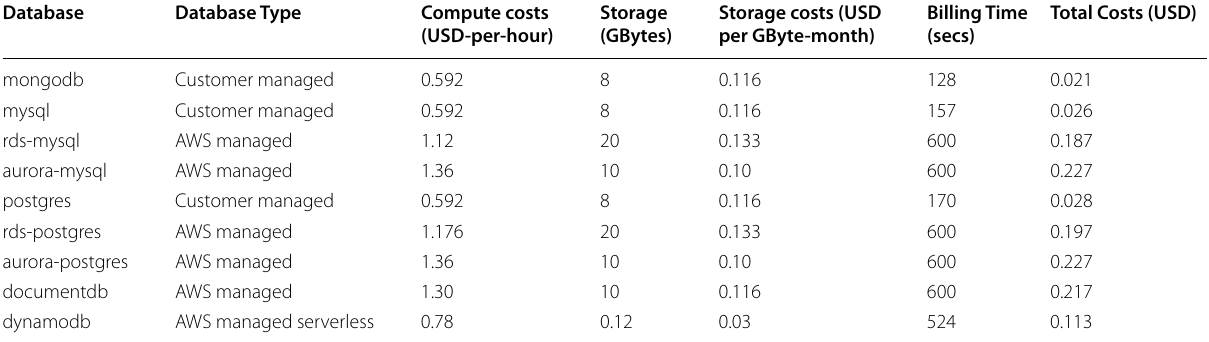
Table 5 Running costs (as on 1 st December